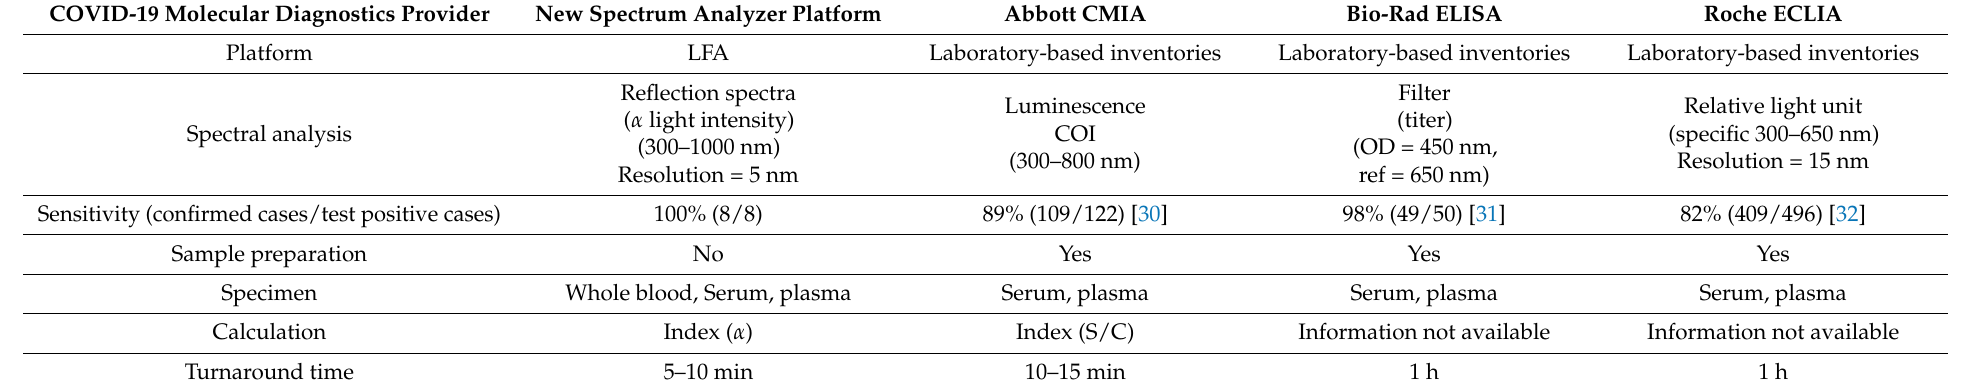
Table 3. The comparison of commercially available chemiluminescent immunoassay kits and analyzers for COVID-19